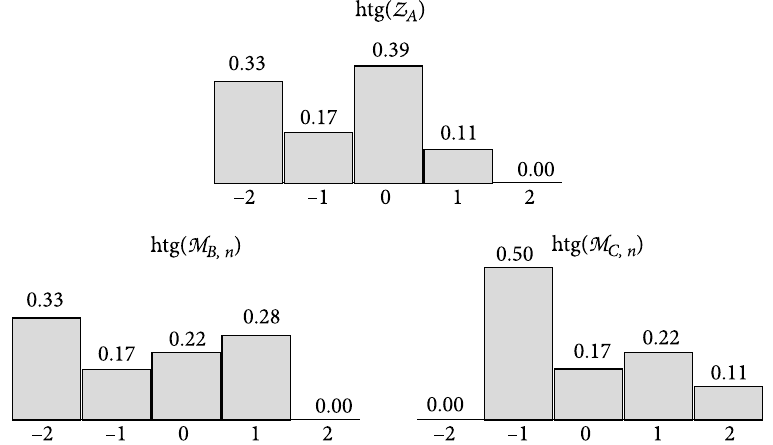
Fig. 1. Example: histograms of trust values distributions for agents A, B and